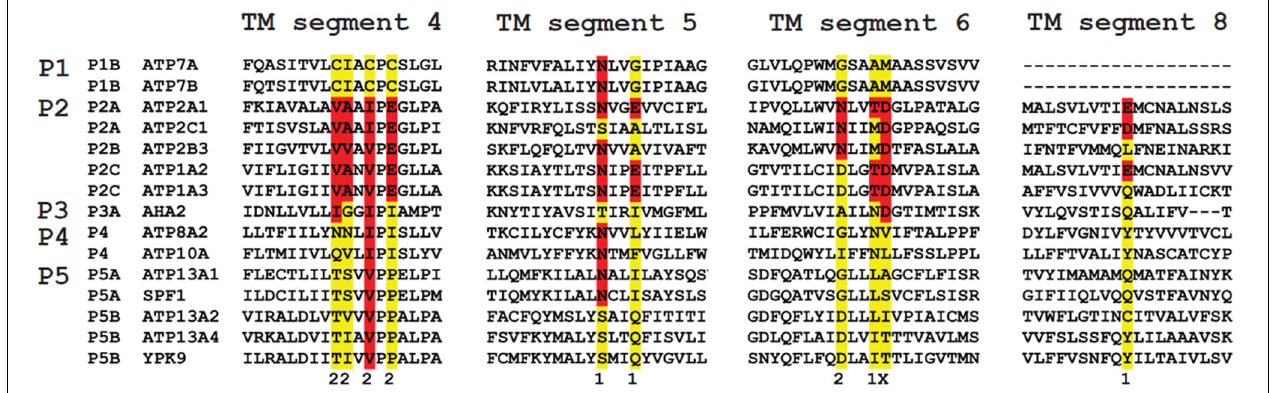
FIGURE 4 | Sequence comparison of the TM helices in P-type ATPases of various subfamilies. The residues involved in Ca 2 + binding in the two Ca 2 + binding sites (site 1 and 2) in the SERCA1a Ca 2 + pump (ATP2A1) are distributed over four TM helices: M4, 5, 6 and 8. The colored residues are part of the Ca 2 + binding sites in ATP2A1 and numbers 1 and 2 refer to the number of the Ca 2 + -binding site to which the residue contributes (x is contributing to both site 1 and site 2). The sequence of the M4, M5, M6 and M8 helices is compared with those of the P-type ATPases that are involved in neurological disorders. Also the yeast P5 ATPases Spf1p and Ypk9p, the